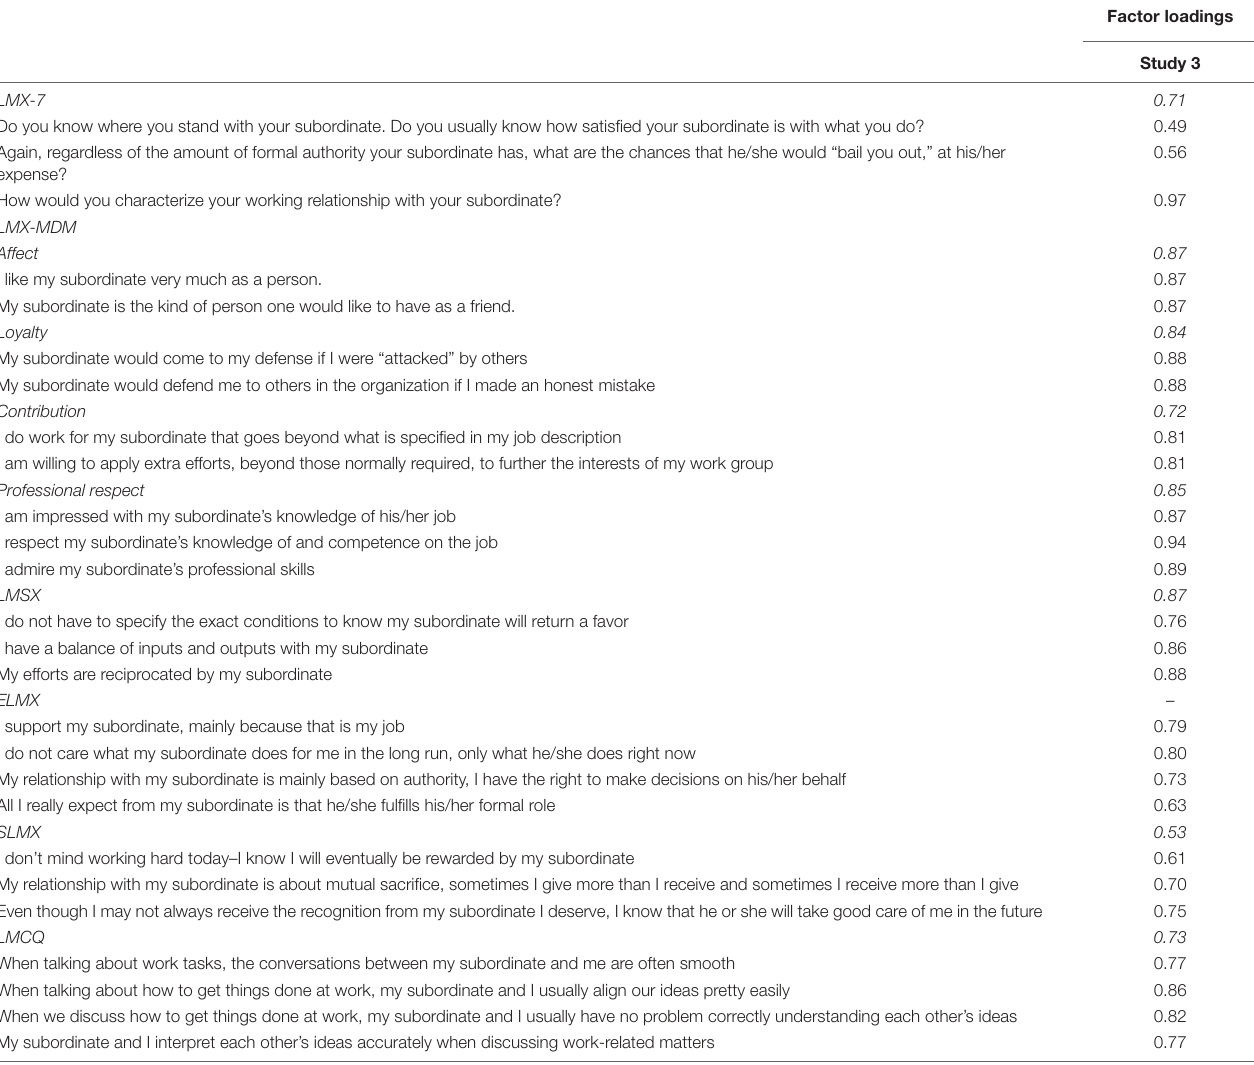
TABLE 7 | Supervisor items and factor